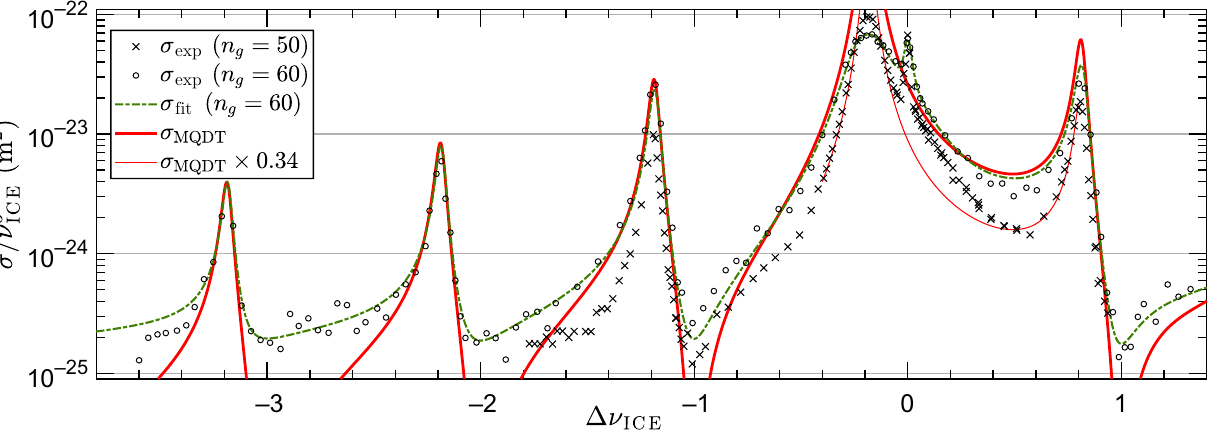
FIG. 4. Results of AI-spectra measurements, displayed as overall ionization cross sections σ exp rescaled by 1 /ν 3 for n g = 50 ICE (crosses) and n g = 60 (circles). Each data point corresponds to the average over 100–500 measurements. The cross section σ fit (dashed- dotted green line), fitted from the experimental n g = 60 ionization probability T exp , is plotted together with the theoretical cross section σ MQDT (thick red plain line) computed from the fitted values of R (cid:2) and δ e for comparison. The peak value predicted for = 1.2 × 10 − 21 m 2 and corresponds to a saturation coefficient the AI cross section at the AI resonance, (cid:4)ν ICE (cid:7) − 0.19, is σ/ν 3 ICE σ(cid:6) T ∼ 50 (see Sec. II B). The n = 50 AI cross section is found to be smaller than the theoretical predictions by a factor (cid:7) 0.34: ICE g for comparison, we also plot a reduced theoretical MQDT cross section (thin red line). The n g = 50 data exhibit an additional pedestal centered at (cid:4)ν ICE = 0, manifested as a mismatch between σ exp and σ MQDT × 0.34: it is interpreted as a Förster resonant energy transfer (Appendix